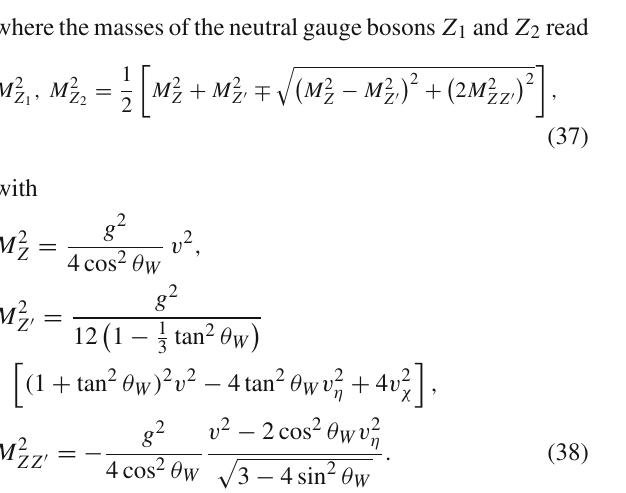
TeV [67,85]. Applying this bound in Eq. (37) and using the values for v η and v ρ obtained above, we have that v χ (cid:2) 7 . 31 TeV. Thus, we can use these VEVs to estimate lower limits for λ 7 , λ 8 and λ 9 in terms of the value of | λ 15 | | λ 15 (cid:2) − 1 . 02 λ 7